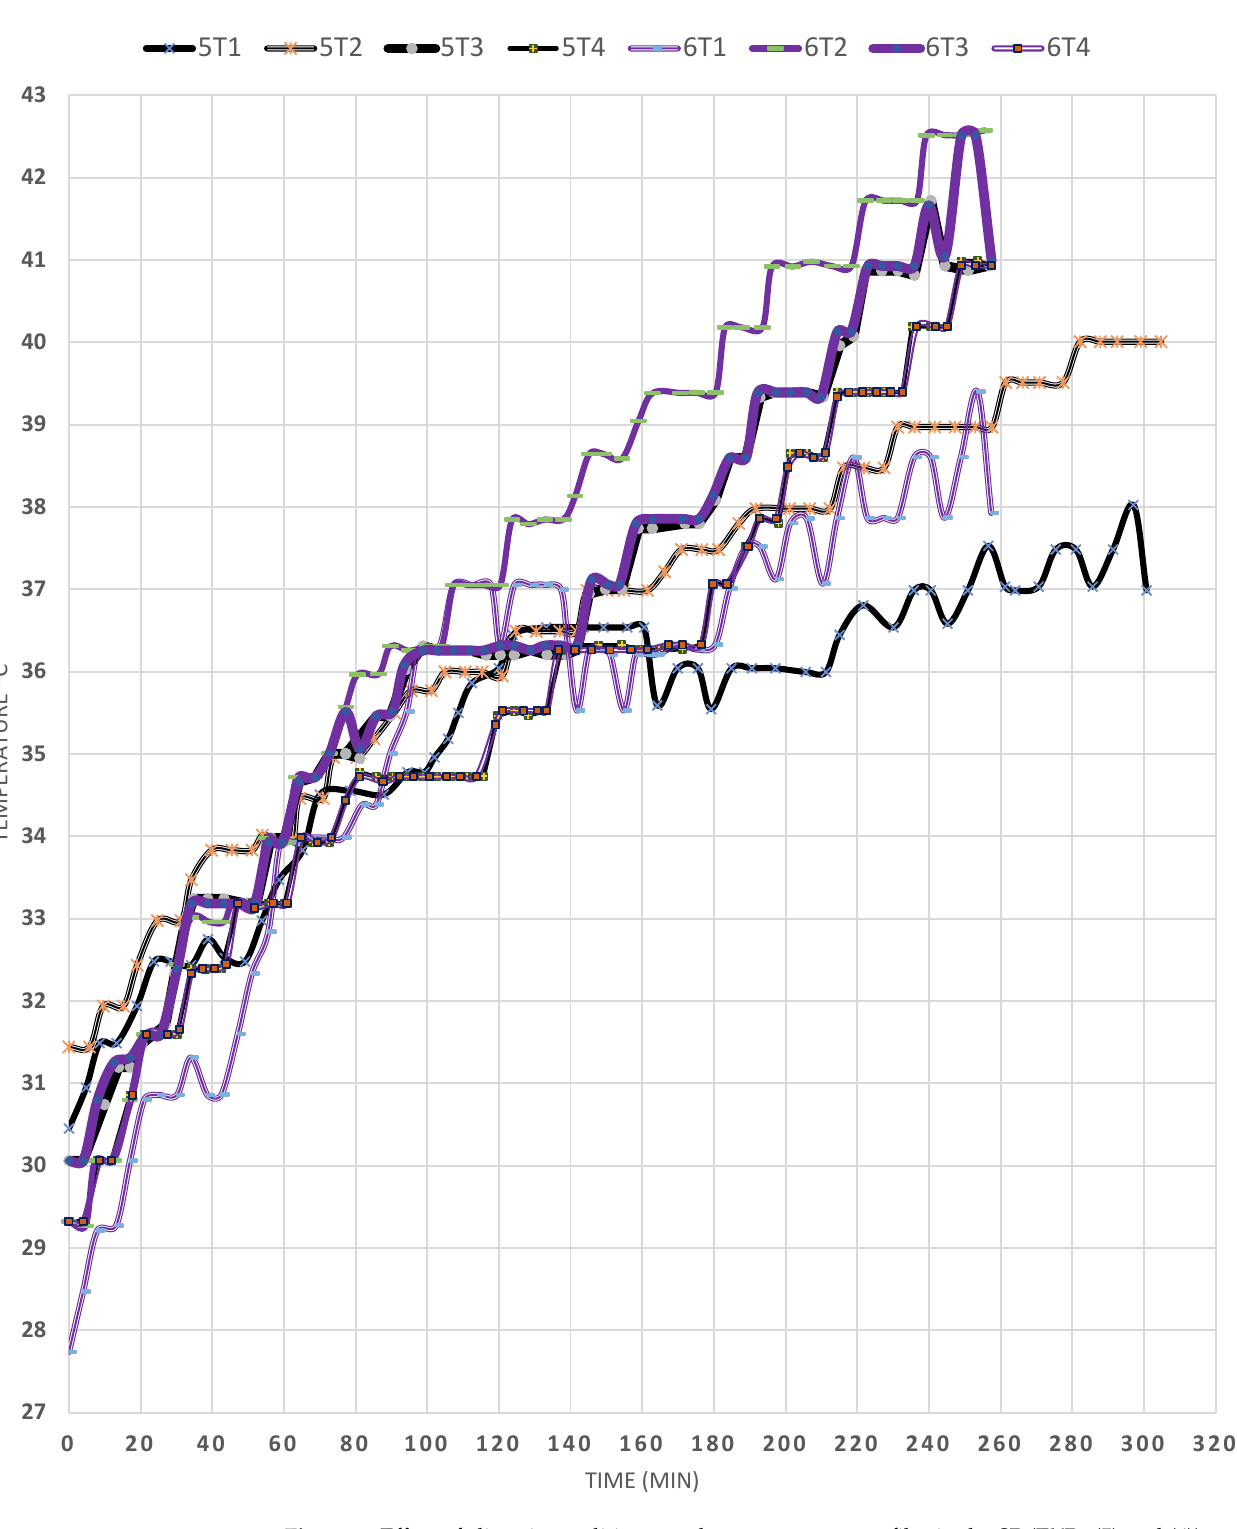
Figure 5. Effect of climatic conditions on the temperature profiles in the SP (EXPs (5) and (6)).